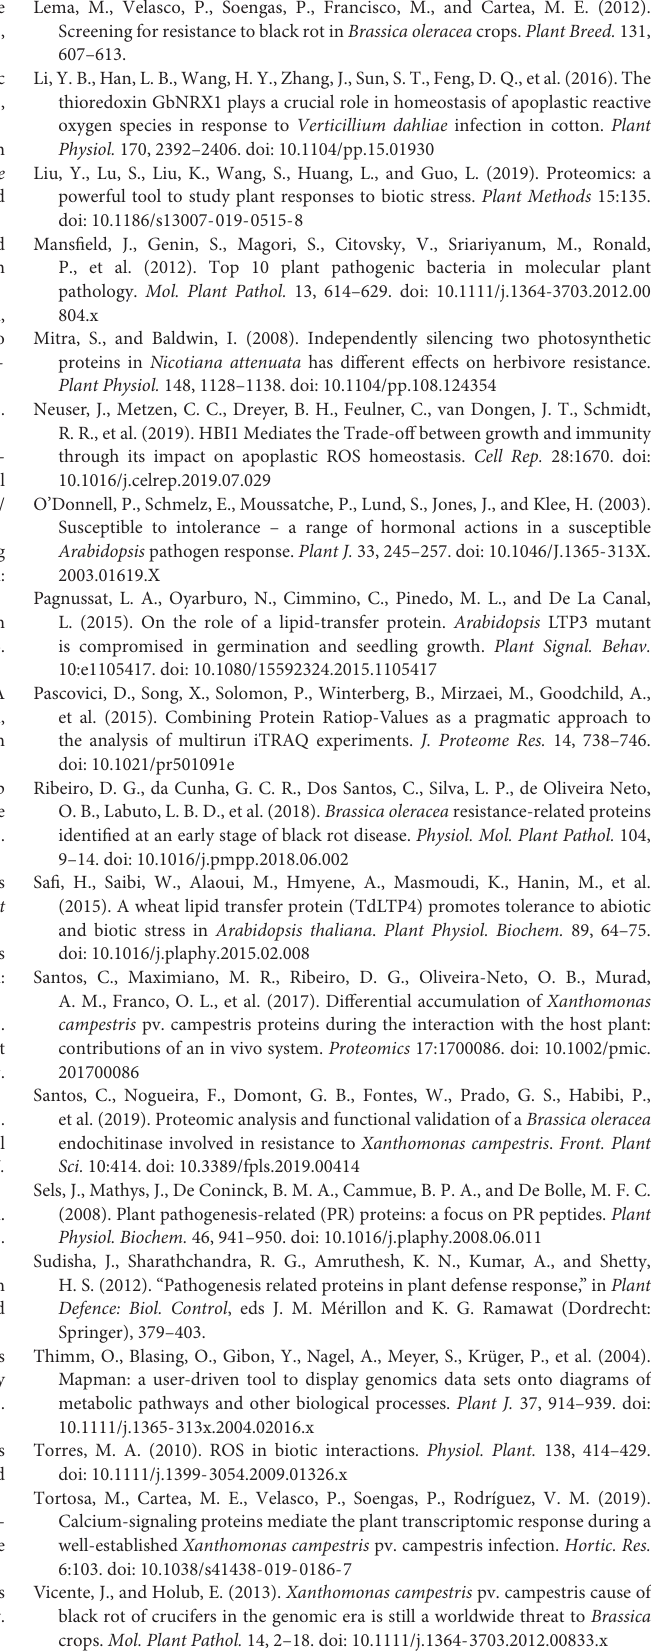
Frontiers in Plant Science |